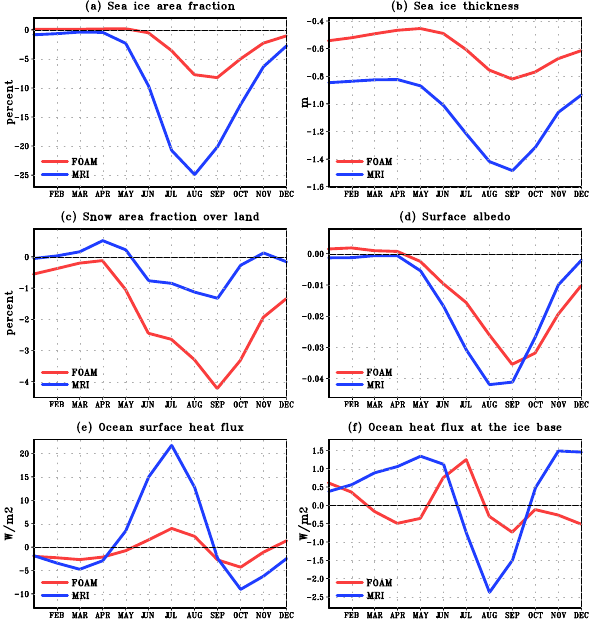
Fig. 7. Change in seasonal variation of (a) Sea ice area fraction (%), (b) Sea thickness( m ), (c) Snow area fractions over land (%), (d) Surface albedo, (e) Downward ocean surface heat flux (W/m 2 , positive means ocean receive heat from atmosphere), and (f) Up- ward ocean heat flux at the ice base (W/m 2 , positive means ocean release heat to atmosphere). The area average is calculated for the 60 ◦ N–90 ◦ N latitudes in FOAM-OA (red curve) and MRI-OA (blue